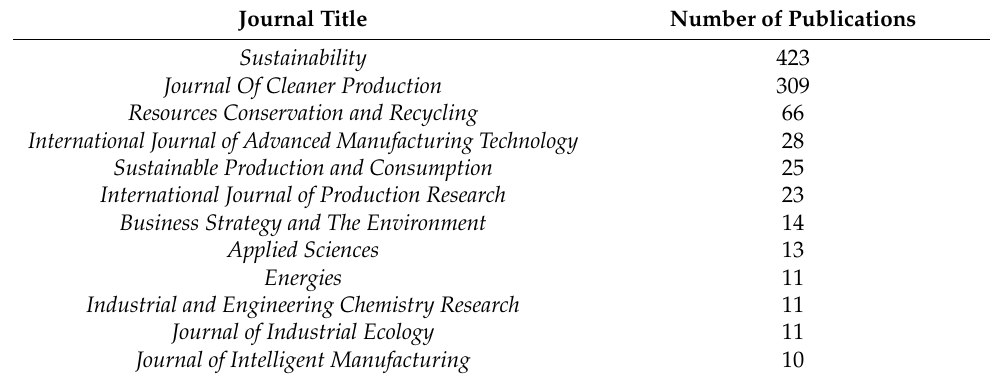
Table 4. The main journals published in combining the five searches. Top 1000 results were